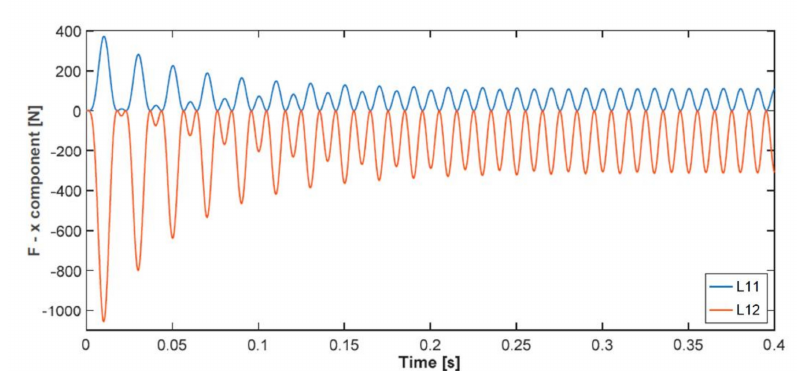
Figure 14. Electrodynamic forces on earthing knifes L11 and L12 [26].